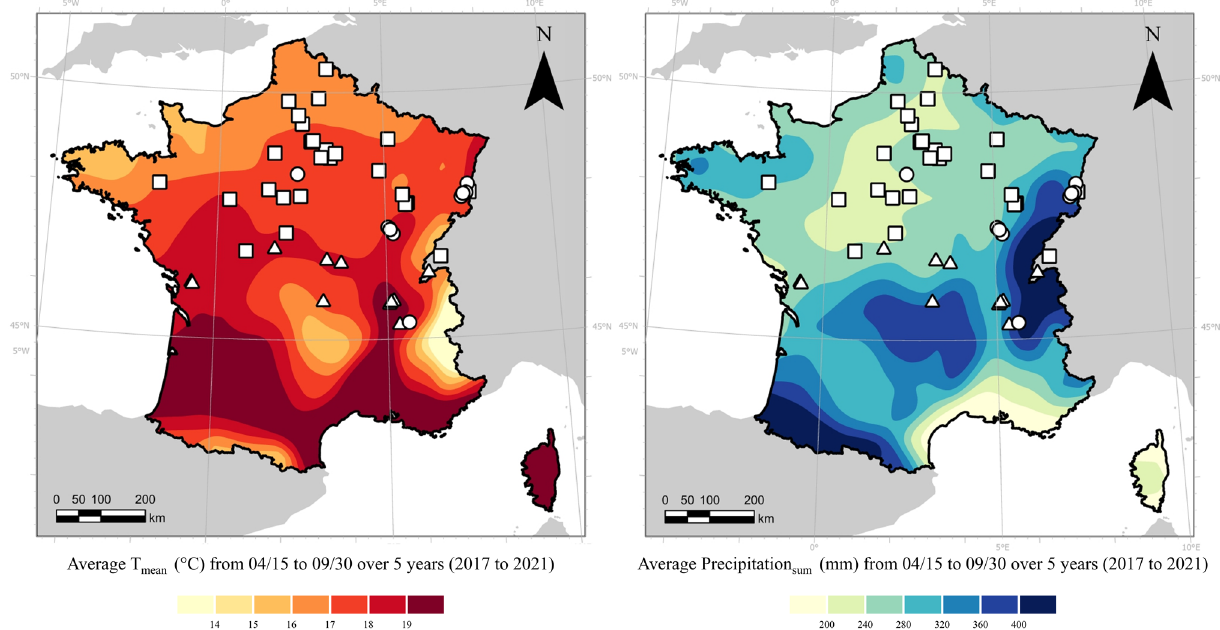
Figure 1. Geographical repartition of the Multi-Environmental Trial (MET) under French climatic conditions. The MET is constituted of 112 environments (a result of the unbalanced combination of 60 locations and five years). Both maps indicate the trials’ positioning over the five years (2017 to 2021) by tested maturity: MG000 ( □ ), MG00 ( Δ ) and both ( ○ ). The maps show a colour gradient of mean temperature (left) and cumulative precipitation (right) over the five years, calculated on the average growing period from 15 April to 30 September (data source: Joint Research Centre meteorological data).